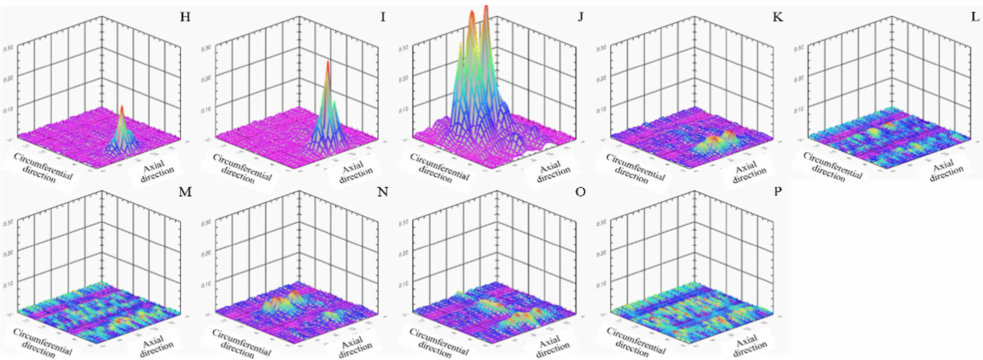
Figure 13. 3D image of the T-EMF from the BIGiS for the specimen with multisite flaws (30 kHz AC).